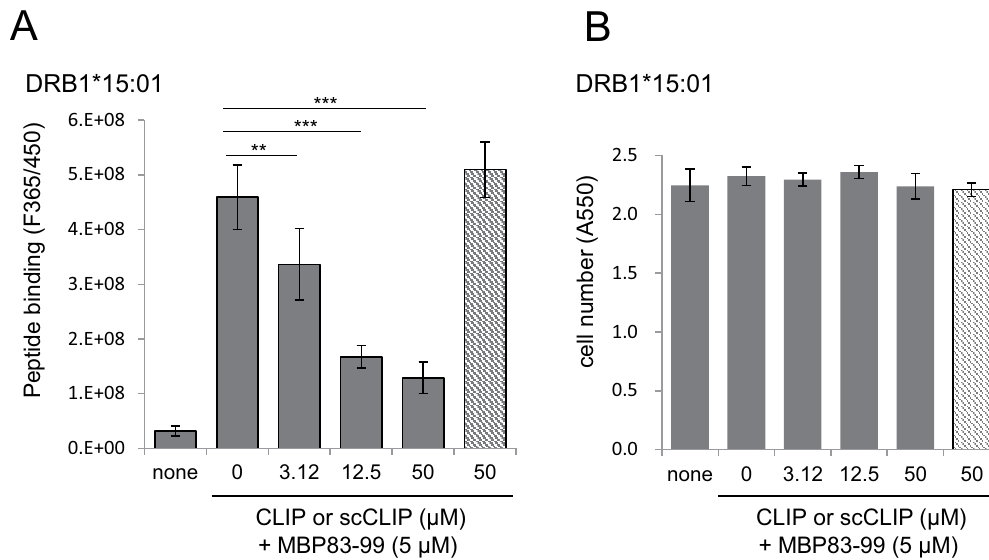
Figure 4. Effect of CLIP102-118 on the loading of MBP83-99 to HLA-expressing 3T3 cells in 96-well plates. ( A ) Effects of CLIP and scCLIP on MBP83-99 loading to DR15-expressing cells. ( B ) Cytotoxicity of CLIP. DR15- expressing 3T3 cells in 96-well plates were incubated without or with the indicated concentration of CLIP (filled bar) or scCLIP (hatched bar) for 1 h, and then exposed to MBP83-99 for 6 h. Bound peptides were detected as in (Fig. 3). After fluorescence measurement, the remaining cells in each well of were detected by crystal violet staining for cytotoxicity analysis. Values shown are mean ± intra-assay deviation expressed as SD from 3 to 6 wells in one representative result. ** P < 0.01, *** P <